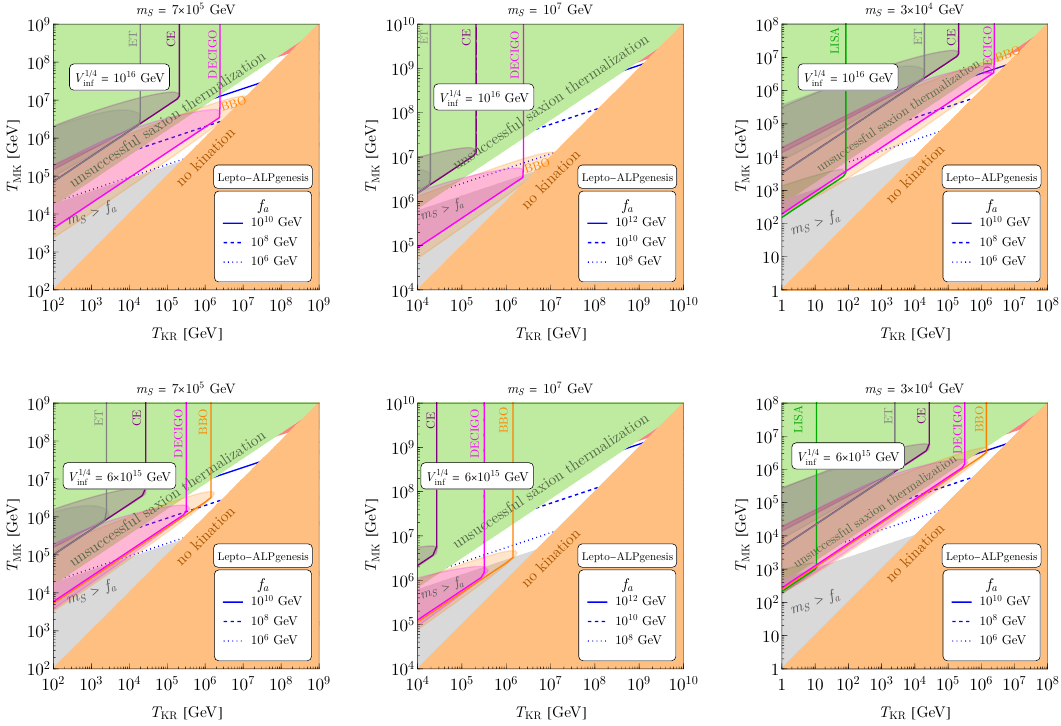
Figure 11 . Possible ranges of temperatures are shown for lepto-ALPgenesis. The left two columns are for the case with entropy production from saxion domination ( D = 1 ), while the right column assumes radiation domination ( D = O (20) ) with degenerated neutrinos. These different cases are explained in section 4.2 and ref. [60]. The dark matter abundance is explained by an appropriate ALP mass determined by f a and T KR using figure 5. Thanks to a kination era, the primordial gravitational waves for V 1 / 4 = 10 16 GeV ( 6 × 10 15 GeV ) in the upper (lower) panels become inf detectable by the experiments labeled next to the colored sensitivity curves. The transparent colored shadings indicate that the peak of the gravitational wave spectrum due to kination lies inside the corresponding experimental